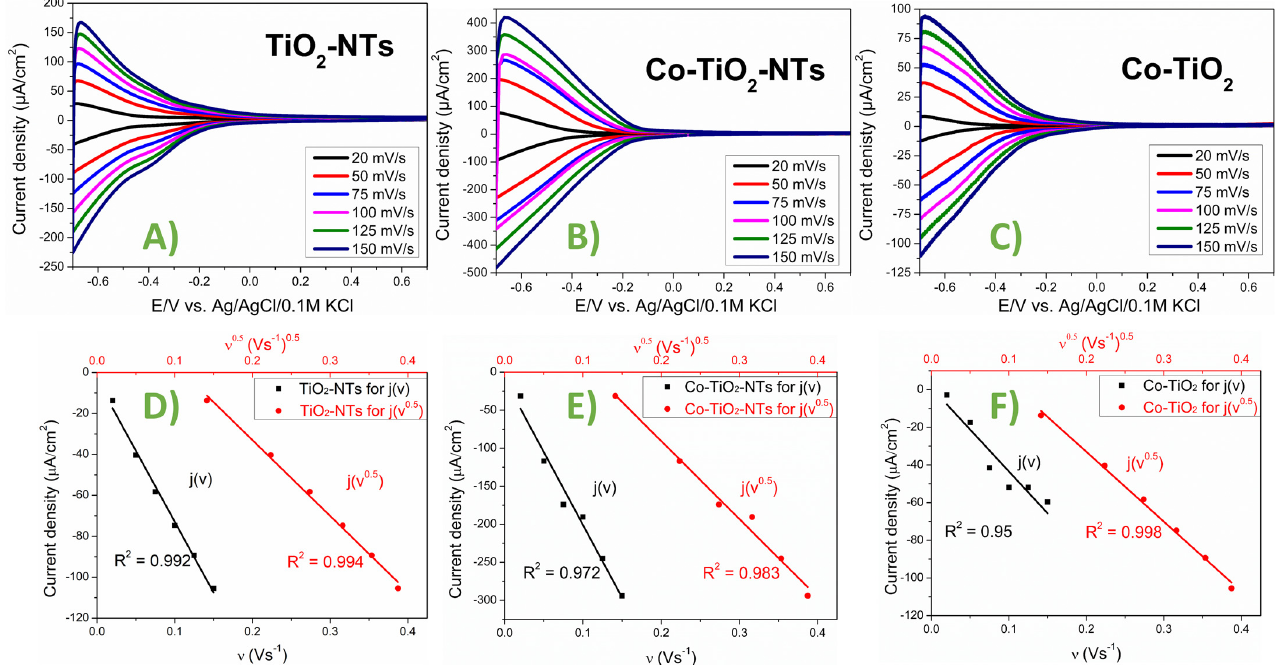
Figure 7. Cyclic voltammetry (CV) curves obtained at varied sweep rates and analysis: ( A , D ) TiO 2 -NTs; ( B , E ) CoTiO 2 -NTs; ( C , F ) Co-TiO 2 .